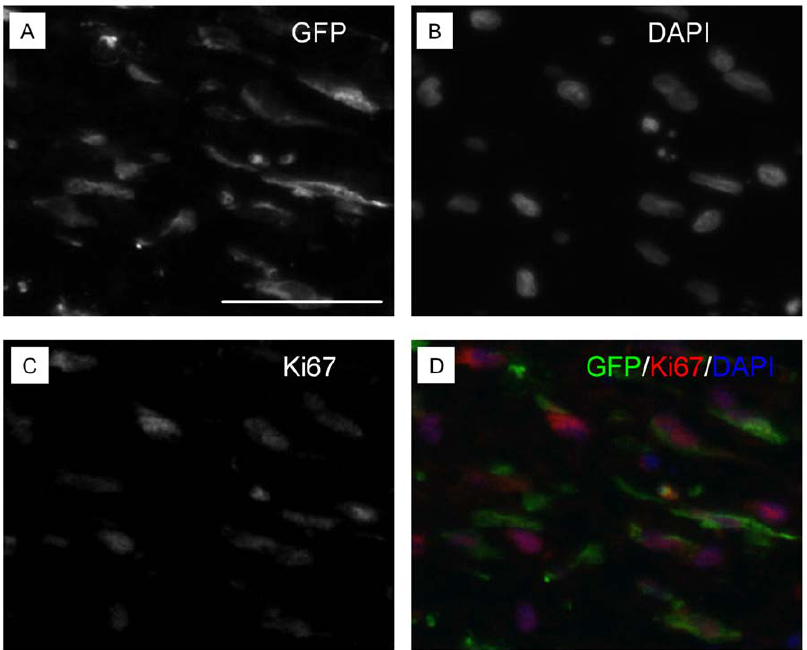
Figure 5. Transplanted ASCs proliferate in wounds. GFP-expressing ASCs were analyzed 7 days after transplantation in wounds. Chicken anti- GFP (A) and mouse anti-Ki67 (C) antibodies were used. Nuclei were stained with DAPI (B). Merged image was shown in D. Scale bars: 50 m m.